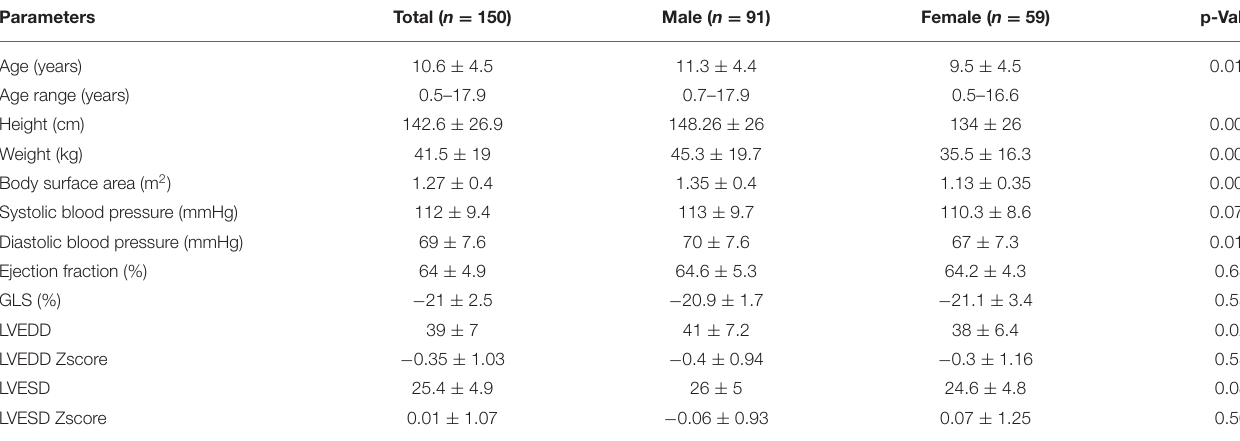
TABLE 1 | Characteristics of the population.